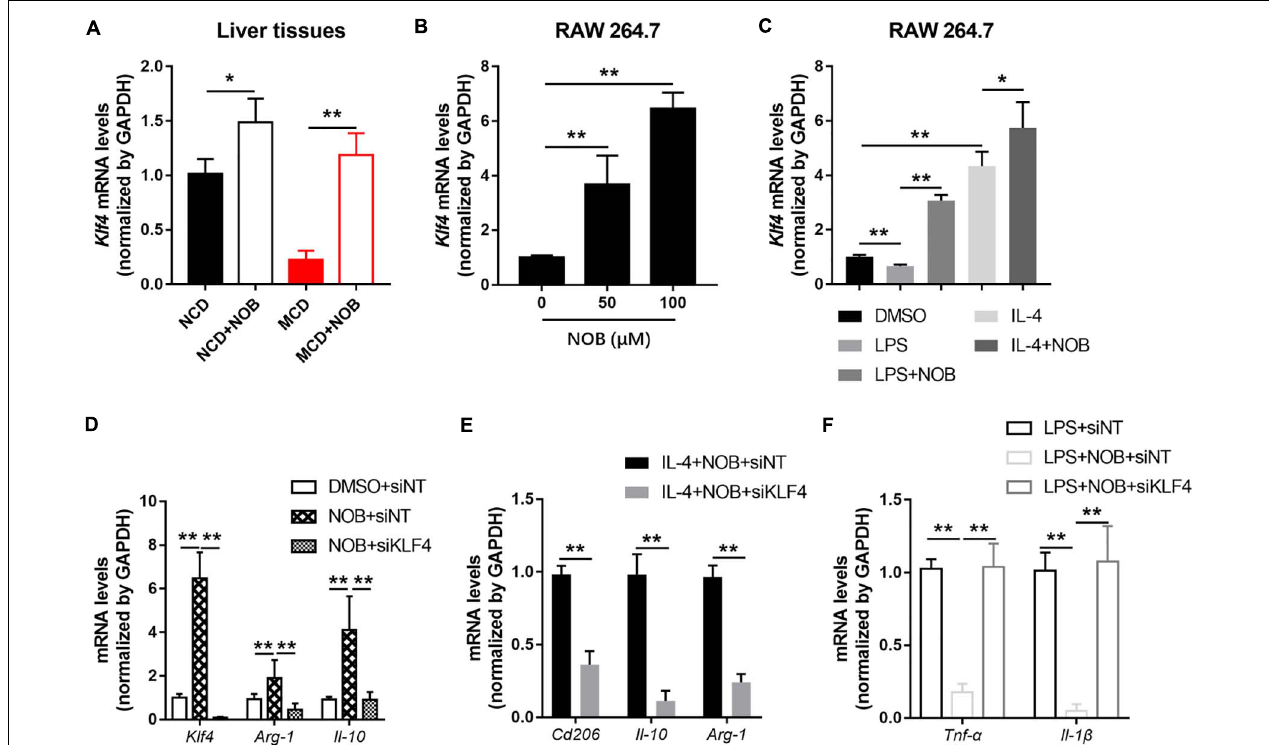
FIGURE 6 | NOB promotes M2 polarization through increasing Klf4 expression. (A) The mRNA expression of Klf4 in the livers of MCD-fed mice was evaluated by RT-qPCR. Data were expressed as the mean ± SD ( n = 5). (B) RAW 264.7 cells were treated with DMSO, NOB (50 µ M) or NOB (100 µ M) for 16 h. The mRNA expression of Klf4 was determined by RT-qPCR. (C) RAW 264.7 cells were pretreated with DMSO, LPS (200 ng/mL), LPS (200 ng/mL) + NOB (100 µ M), IL-4 (20 ng/mL), or IL-4 (20 ng/mL) + NOB (100 µ M) for 16 h. The mRNA expression of Klf4 was measured by RT-qPCR. (D) RAW 264.7 cells were transiently transfected with control (siNT) or KLF4 (siKLF4) siRNA and treated with either DMSO or NOB for 16 h as indicated. The mRNA levels of Klf4 , Arg-1, and Il-10 were determined by RT-qPCR. (E) The siRNA-NT or siRNA-KLF4 cells were treated with IL-4 (20 ng/mL) + NOB (100 µ M) for 16 h. The mRNA levels of Cd206 , Arg-1, and Il-10 were measured by RT-qPCR. (F) The siRNA-NT cells were treated with LPS (2,00 ng/mL) or LPS (200 ng/mL) + NOB (100 µ M). The siRNA-KLF4 cells were treated with LPS (200 ng/mL) + NOB (100 µ M) for 16 h. The mRNA levels of Il-1 β and Tnf- α were quantified by RT-qPCR. Values are expressed as mean ± SD ( n = 3). * P < 0.05, ** P <